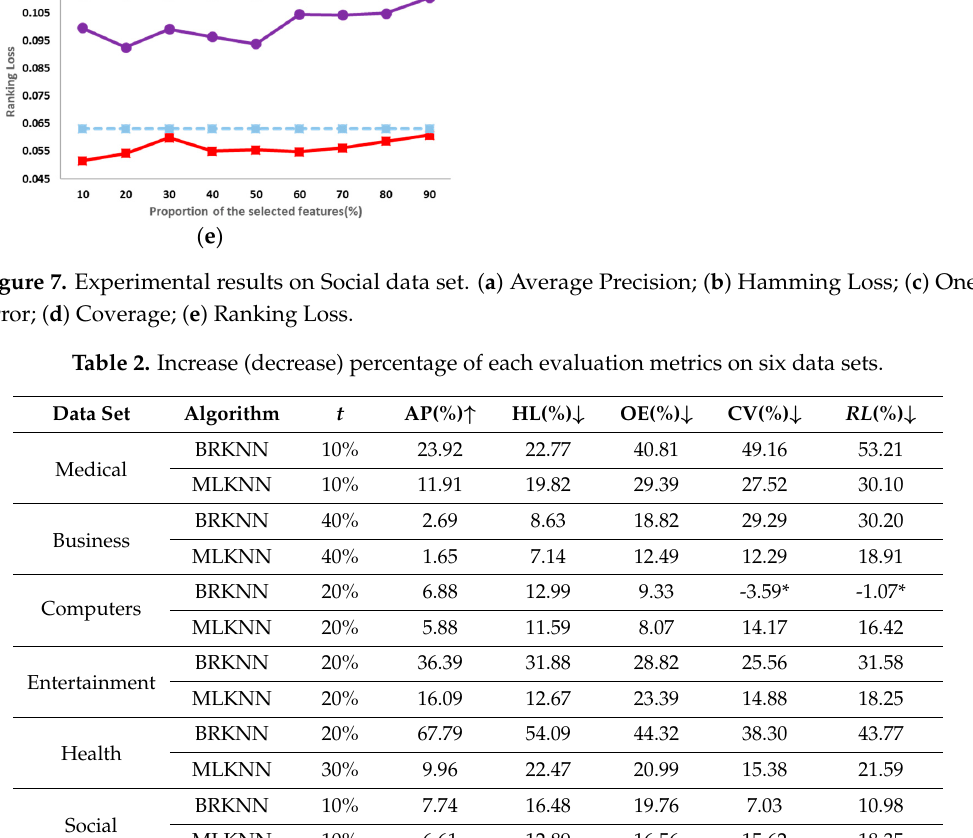
Table 2. Increase (decrease) percentage of each evaluation metrics on six data sets.